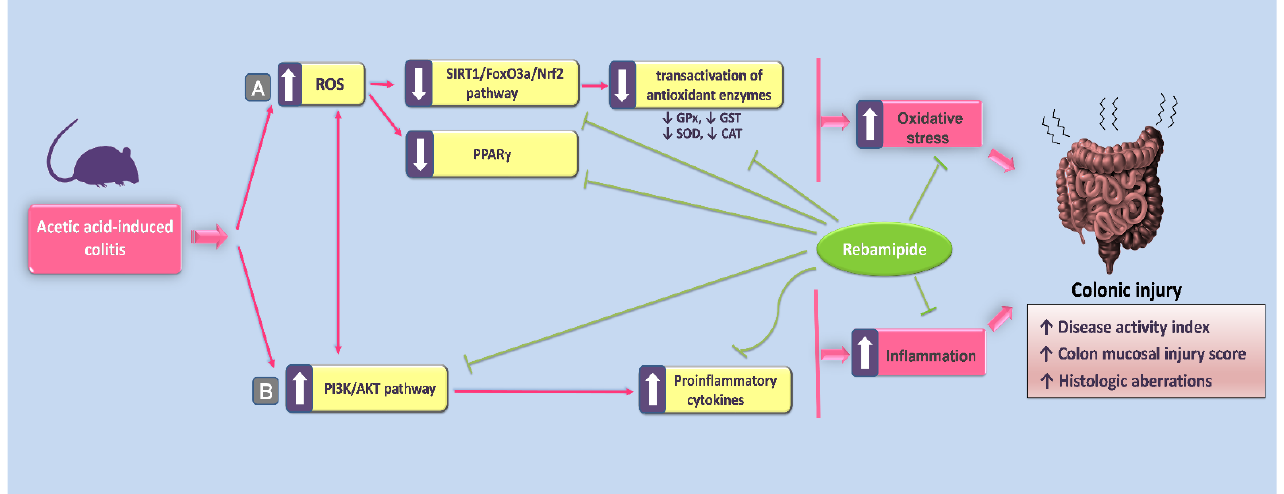
Figure 11. Summary of the proposed underlying molecular mechanisms by which rebamipide attenuates acetic acid-evoked colonic injury. The mechanisms for the beneficial effects of rebamipide against colitis can be summarized as follows: ( A ) Rebamipide curtails the oxidative stress in the colonic microenvironment by counteracting acetic acid-induced inhibition of the silent information regulator-1 (SIRT1)/forkhead box O3a (FoxO3a)/nuclear factor erythroid 2-related factor 2 (Nrf2) pathway and acetic acid-induced depletion of the peroxisome proliferator-activated receptor gamma (PPAR-γ) cytoprotective signal. ( B ) Meanwhile, rebamipide suppressed the inflammatory signals/cytokines by suppressing acetic acid-induced activation of the phosphoinositide 3-kinase (PI3K)/protein kinase B (AKT) pro-inflammatory pathway. In the context of IBD pathogenesis, suppression of the colonic SIRT1/FoxO3a/Nrf2 axis has been previously characterized in experimental IBD models where excessive reactive oxygen species (ROS) generation is associated with lowered expression of SIRT1, FoxO3a, Nrf2, and HO-1 and exaggerated oxidative stress status in the colonic microenvironment [7,23,34,35] . The solid arrow represents activation; the blunt arrow represents inhibition.